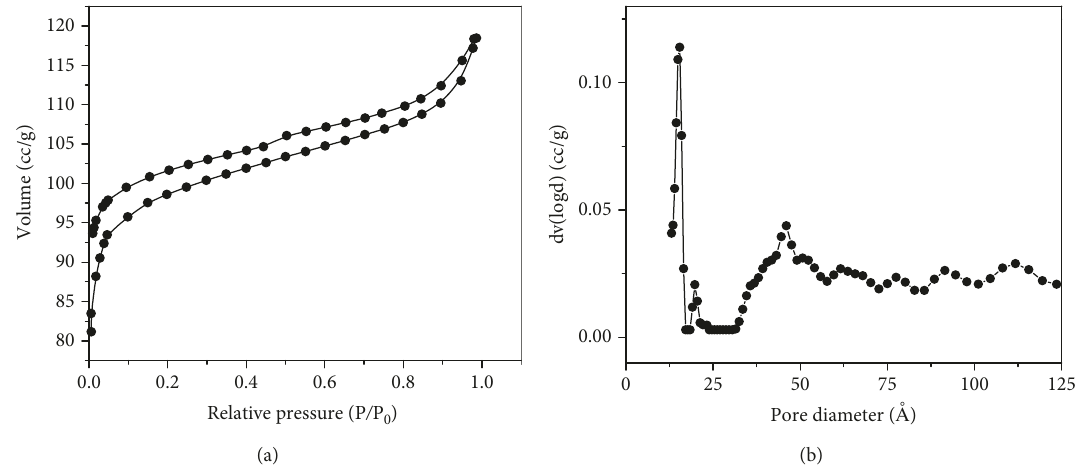
Figure 3: (a) N physisorption isotherm and (b) BJH pore size distribution plot of the AC-ZnO 2